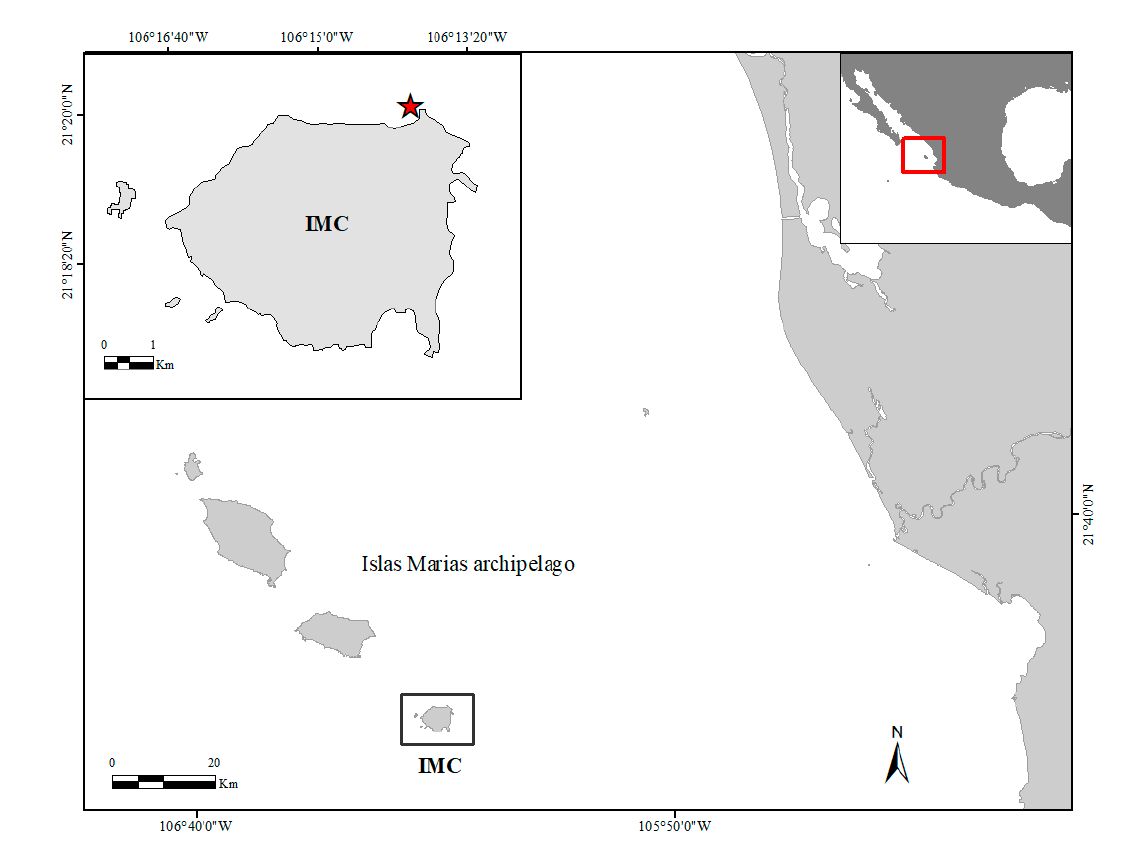
Figure 1. Restoration site (red star) located at Islas María Cleofas (IMC), Islas Marías archipelago in the Central Mexican Pacific (red box).